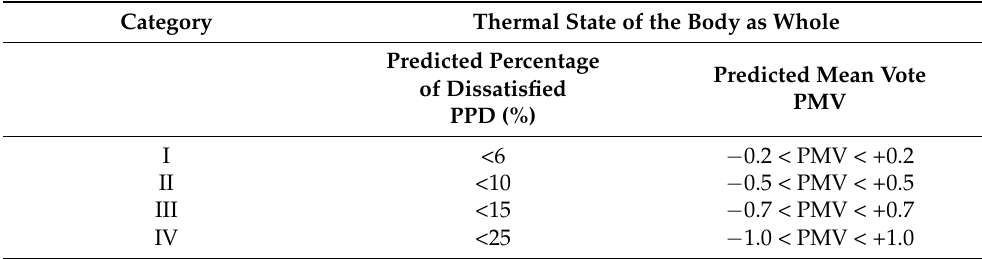
Table 7. Thermal comfort categories for design of mechanically heated and cooled buildings